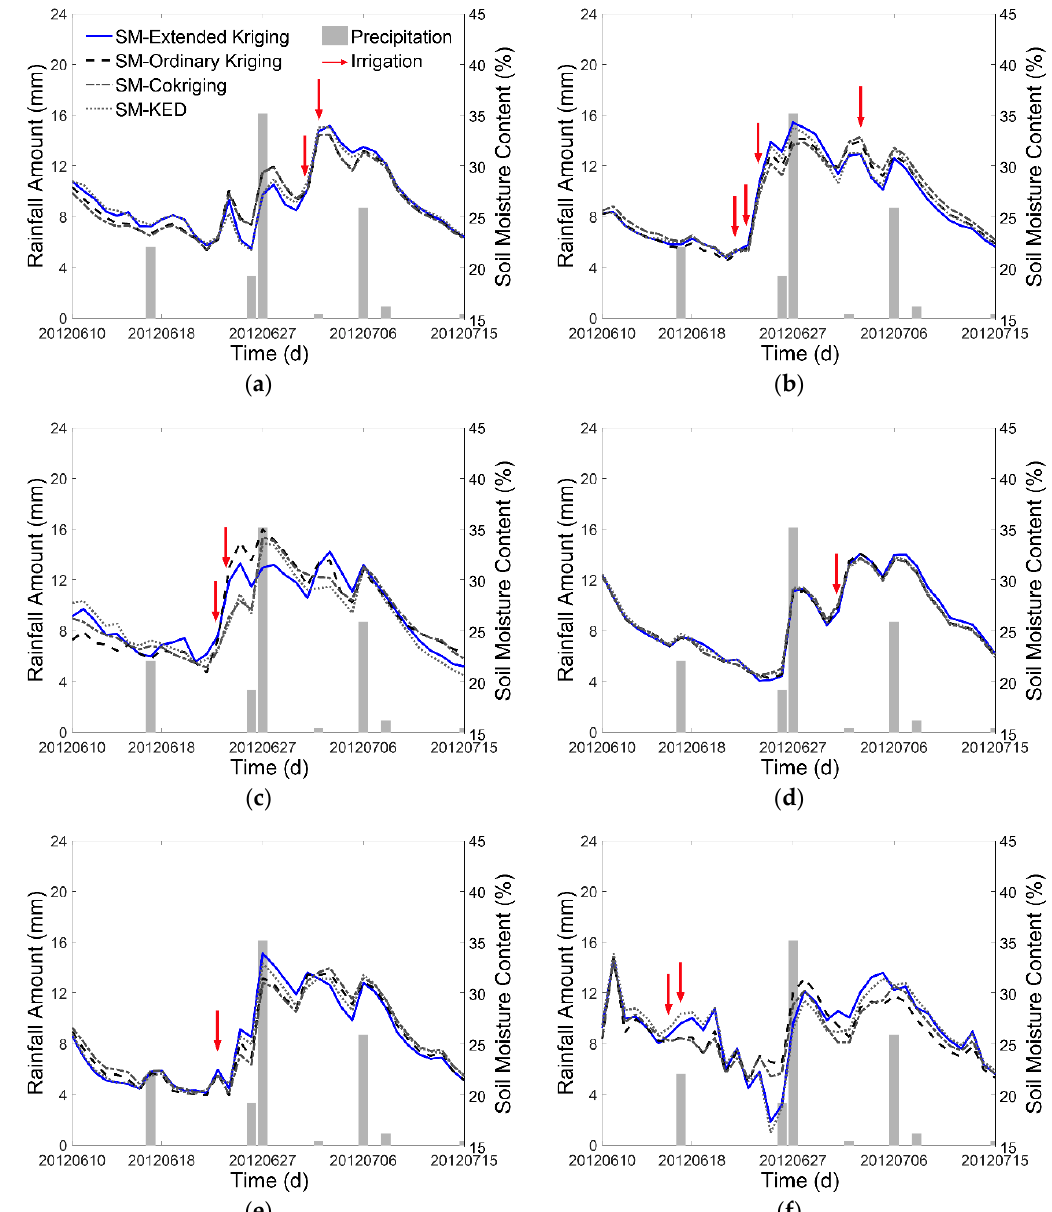
Figure 10. Comparison of soil moisture (SM) changing trend with precipitation and irrigation data of the chosen irrigation fields: ( a ) JC-6; ( b ) SQ-1; ( c ) STZ-1; ( d ) WX-4; ( e ) XM-2; and ( f ) ZH-6; the grey bar represents precipitation; the red arrow represents the irrigation.